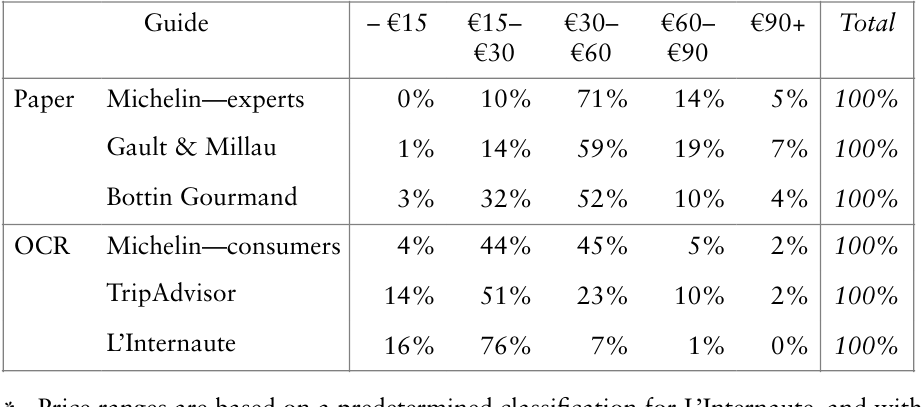
Table 4. Price range and distribution of restaurants.*